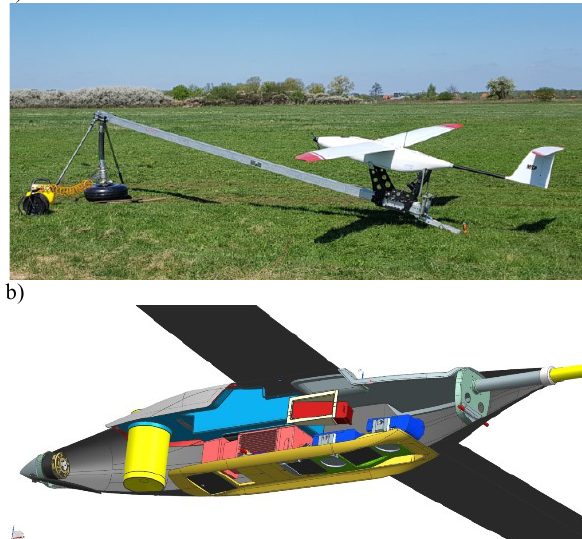
Figure 1. NEO3 on a rail launcher (a) and localisation of the sensors and components in the platform body, in pink (light red) VUX mini-UAV1 scanner in dark blue two Sony Alpha 6000 cameras(b)